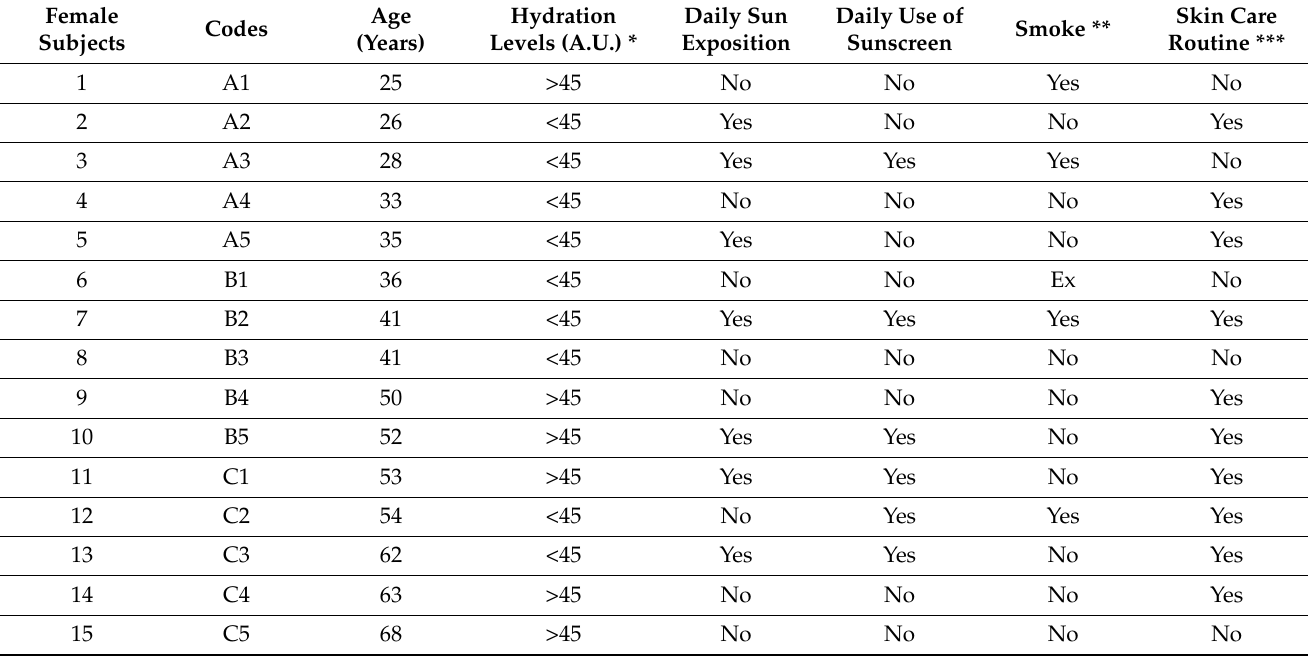
Table 1. Summary of the study population